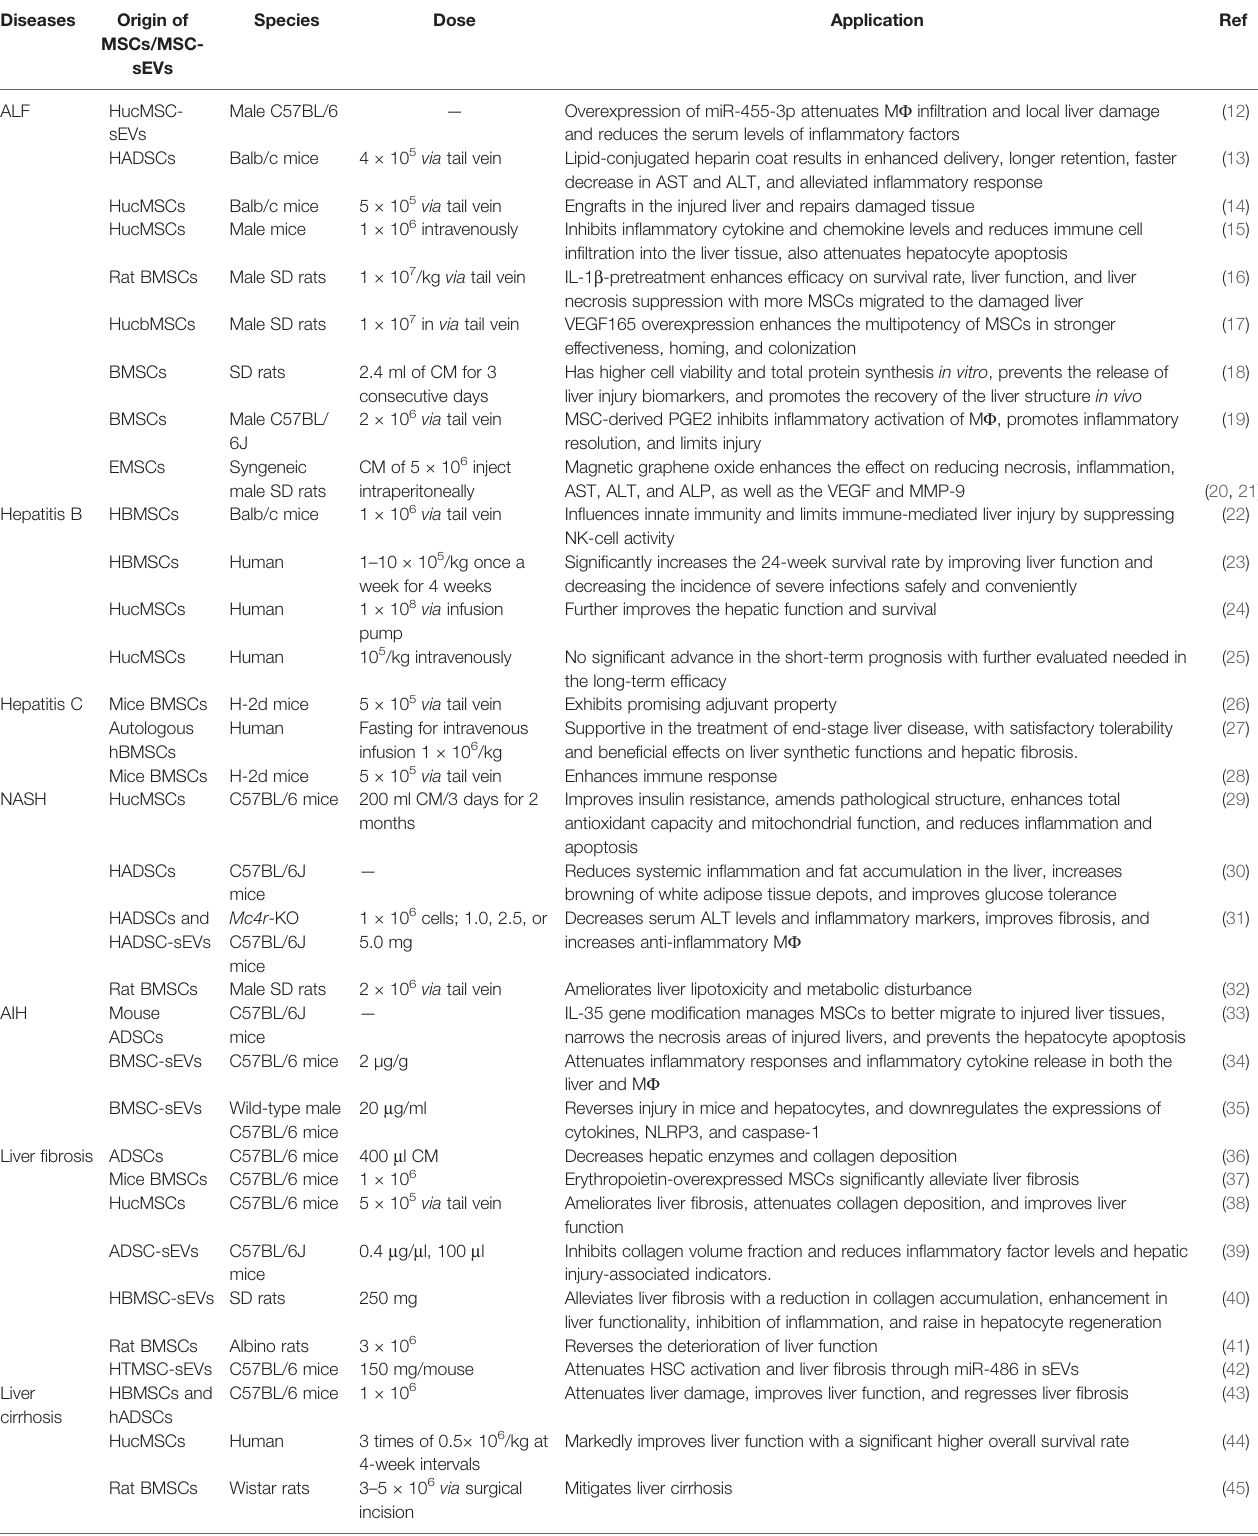
TABLE 1 | Studies testing the immunomodulatory effects of MSCs/MSC-sEVs on liver disease. Diseases Origin of